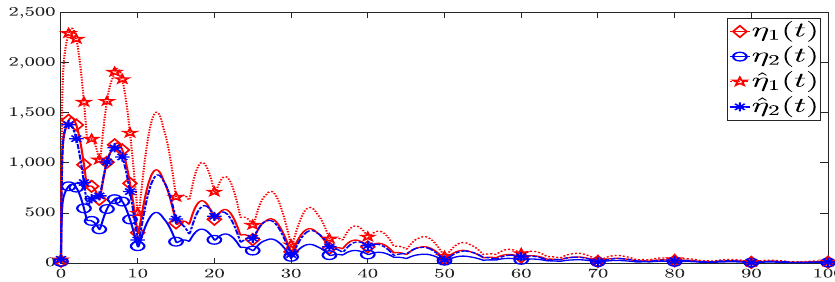
Figure 7. The state trajectories of system (1) with input u (cid:48) ( t ) and disturbance w (cid:48) ( t )